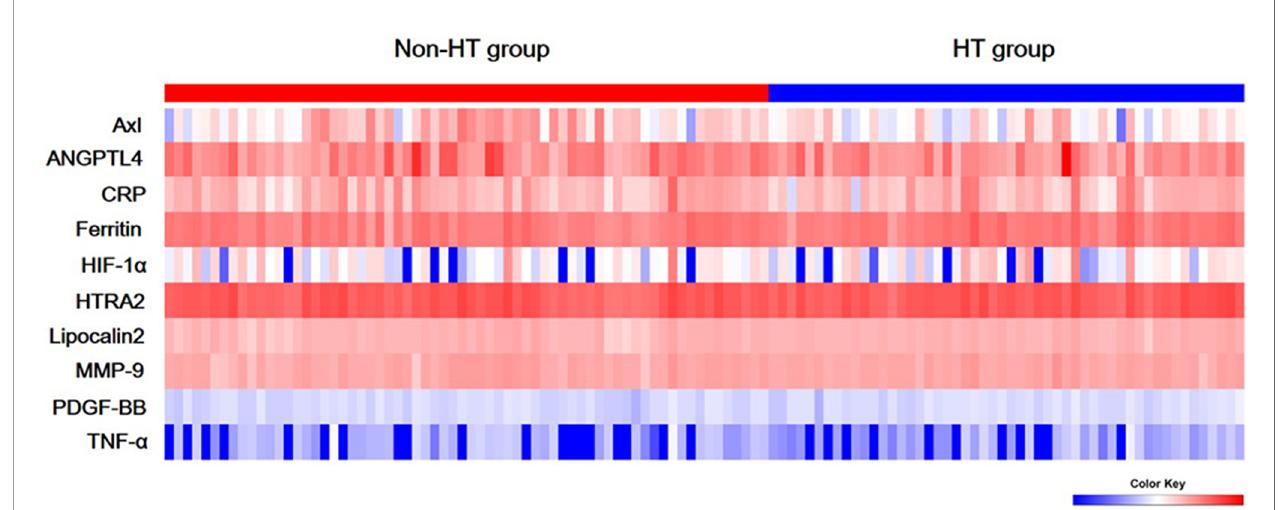
FIGURE 1 | Serum levels of ten biomarkers. Heat map of quantitative protein chip of Axl, angiopoietin-like 4 (ANGPTL4), C-reactive protein (CRP), ferritin, hypoxia- inducible factor-1 alpha (HIF-1 a ), HTRA2, Lipocalin2, Matrix metallopeptidase 9 (MMP-9), platelet-derived growth factor-BB (PDGF-BB), and tumor necrosis factor alpha (TNF- a ) in acute ischemic stroke (AIS) with/without hemorrhagic transformation